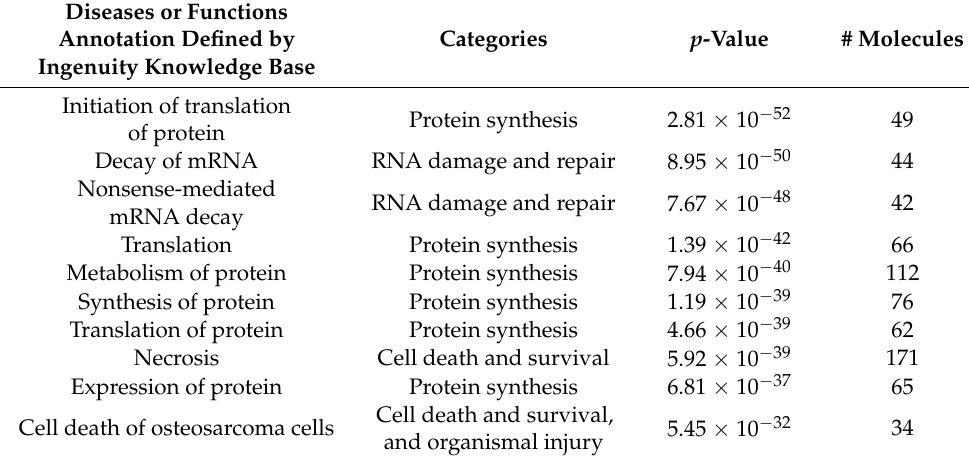
Table 1. The top ten biofunctions identified using the list of 398 common proteins from three biological samples of canine in vitro oviductal cell-derived extracellular vesicles. Diseases or